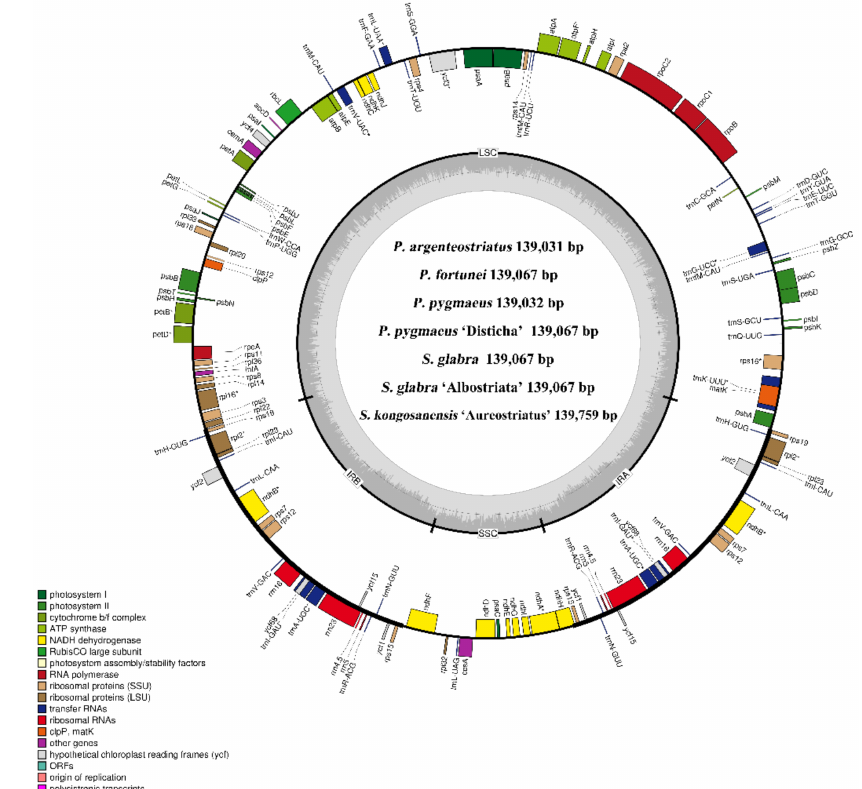
Figure 2. The gene map of the chloroplast genomes of seven ornamental bamboo species. Genes on the inside of the large circle are transcribed clockwise, and those on the outside are transcribed counter clockwise. The color-coding of the genes is determined according to their annotation functions. The GC content of the chloroplast genomes is represented by the dashed